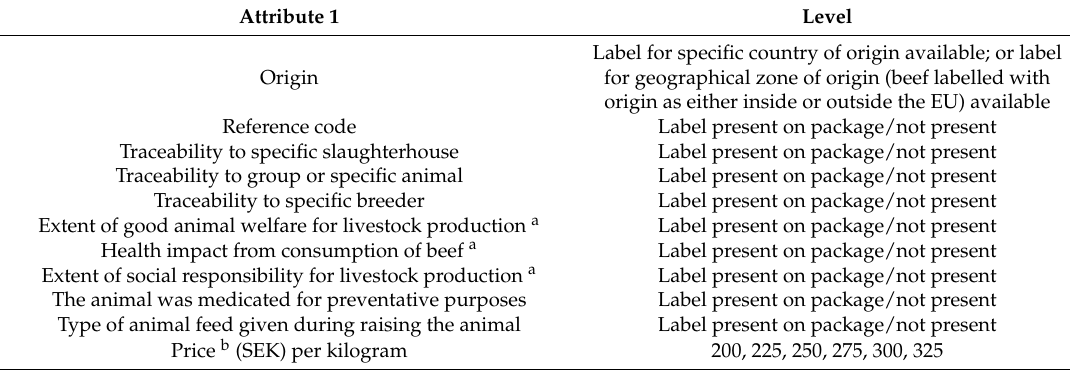
Table 3. The labelling attributes used and their levels in the choice experiment.